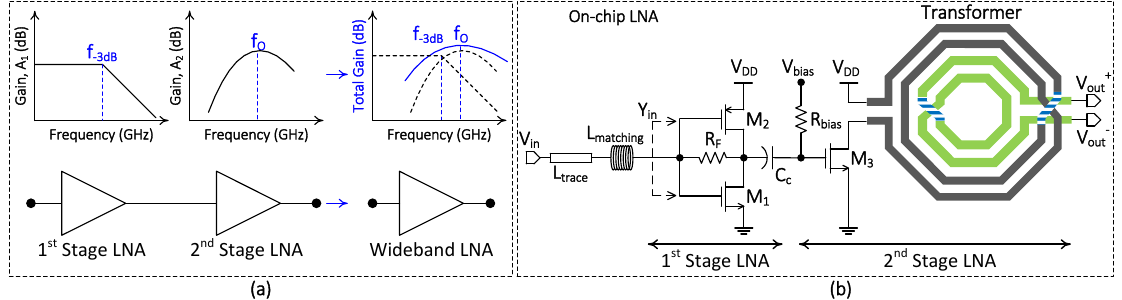
Figure 2. ( a ) LNA architecture and design philosophy; and ( b ) schematic of two-stage LNA with resistive feedback inverter (RFI) as first stage, and transformer-loaded common source configuration as second stage. Table 1. LNA transistor sizing and component values ( top ), and DC operating parameters ( bottom